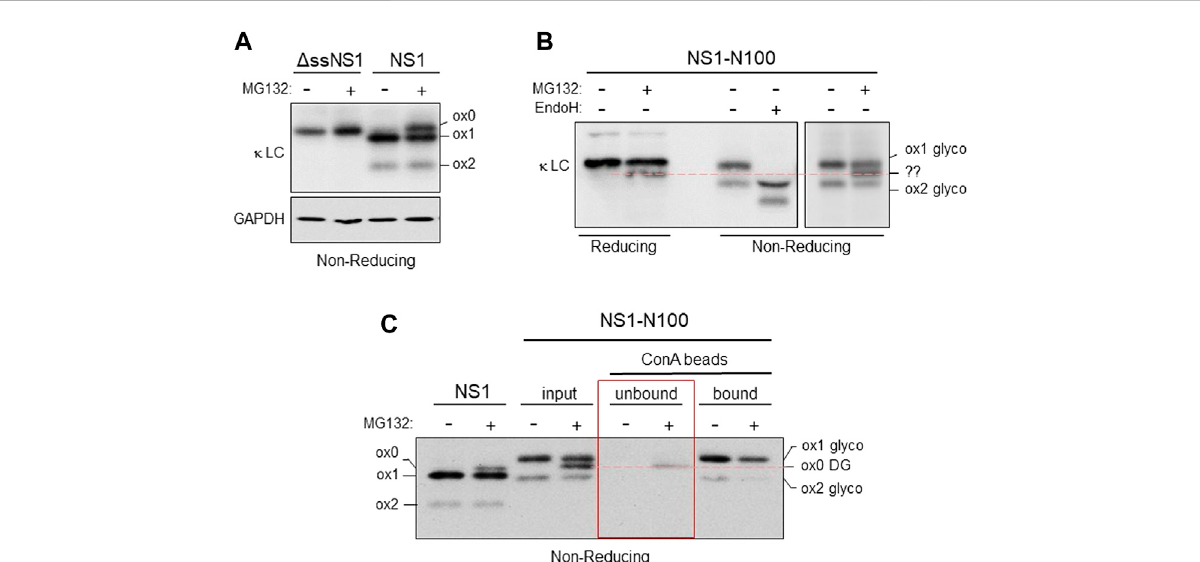
FIGURE 3 BothdomainsarereducedintheretrotranslocatedNS1protein. (A) Cellsweretransfectedwitheitherthecytosolicallyexpressed Δ ssNS1orNS1. After 24 h, cells were treated with (+) or without (-) MG132, and cell lysates were prepared in NP-40 buffer containing NEM. Samples were analyzed by non-reducing SDS-PAGE-coupled western blotting with goat anti-mouse κ antisera. Migration of the various oxidation species (ox0, ox1, ox2) is indicated. (B) Cells expressing NS1-N100were treated with (+) or without (-) MG132 for 3.5 hprior to lysis. Lysates were prepared and analyzed under reducing or non-reducing conditions as indicated. A portion of the lysate from cells not treated with MG132 was digested with Endo H (+) to determine the migration of the deglycosylated ox1 and ox2 species. An unidenti fi ed species (??) generated by proteasomal inhibition observed on non-reducinggelsthat co-migrated with reduced, deglycosylated NS1-N100 isindicated with ared dotted line. (C) 293T cellsexpressing NS1-N100 were incubated with MG132 (+) or DMSO (-). Cells were lysed in NP-40 lysing buffer supplemented with NEM, and a portion of each was kept as an input.TheremaininglysatewasabsorbedwithConA-conjugatedbeads.EquivalentfractionsoftheConA-unboundandthesamplewaselutedfrom the Con A beads (bound) were analyzed by SDS-PAGE conducted under non-reducing conditions and blotted with anti- κ antisera. Bands corresponding to the various redox states are indicated as is their glycosylation status. A red dotted line indicates the species generated by proteasomal inhibition observed panel B is in fact fully reduced and